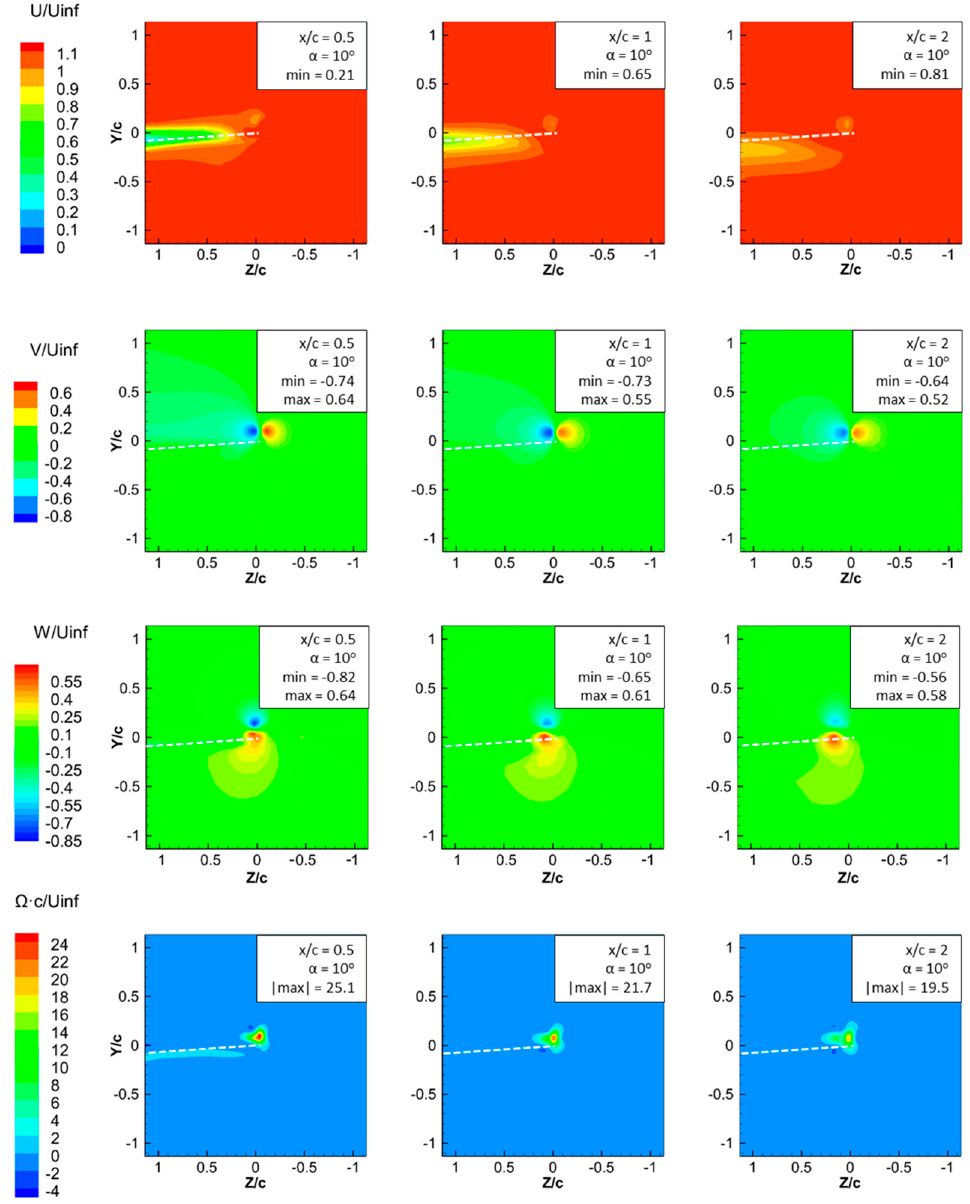
Figure 10. Time-averaged axial, normal and spanwise velocity and vorticity contours at the wingtip. Comparison between the various measurement levels.